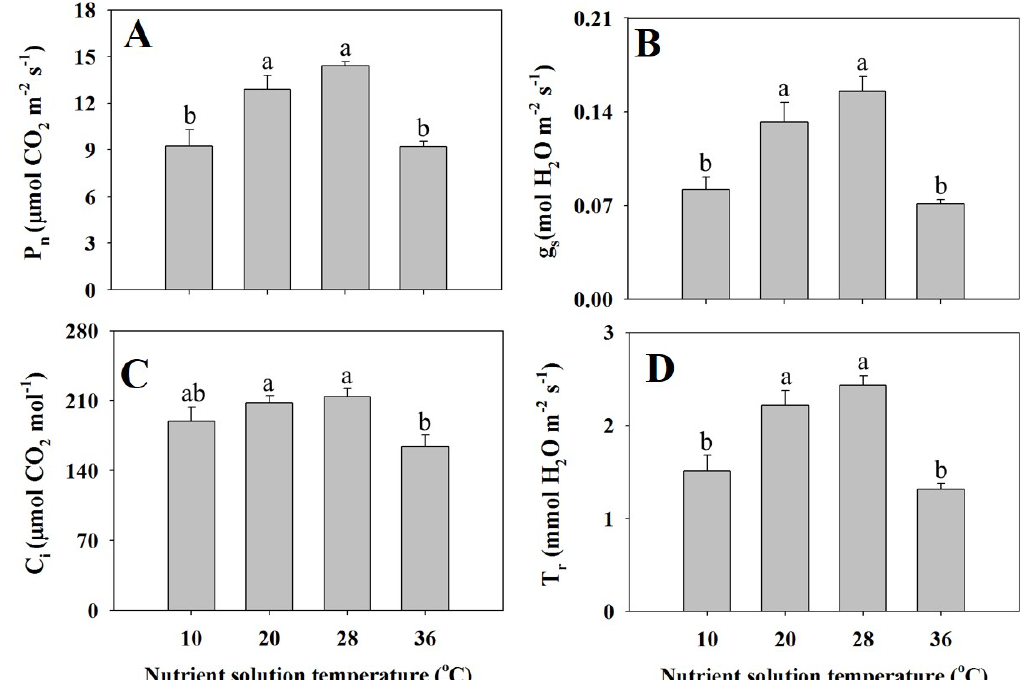
Figure 4. Net photosynthetic rate (Pn) ( A ), stomatal conductance (gs) ( B ), intercellular CO 2 Figure4. Netphotosyntheticrate(Pn)( A ),stomatalconductance(gs)( B ),intercellularCO 2 concentration concentration (Ci) ( C ), and transpiration rate (Tr) ( D ) of A. rugosa at four different root zone (Ci) ( C ), and transpiration rate (Tr) ( D ) of A. rugosa at four di ff erent root zone temperature (RZT) treatments (10, 20, 28, and 36 ◦ C) at 32 days after transplant. Data are shown as the means ± standard temperature (RZT) treatments (10, 20, 28, and 36 °C) at 32 days after transplant. Data are shown as the error (SE) (n = 5). Di ff erent letters (a and b) show significant di ff erences among the RZT treatments means ± standard error (SE) (n = 5). Different letters (a and b) show significant differences among the (Tukey’s test, p < RZT treatments (Tukey’s test, p < 0.05).